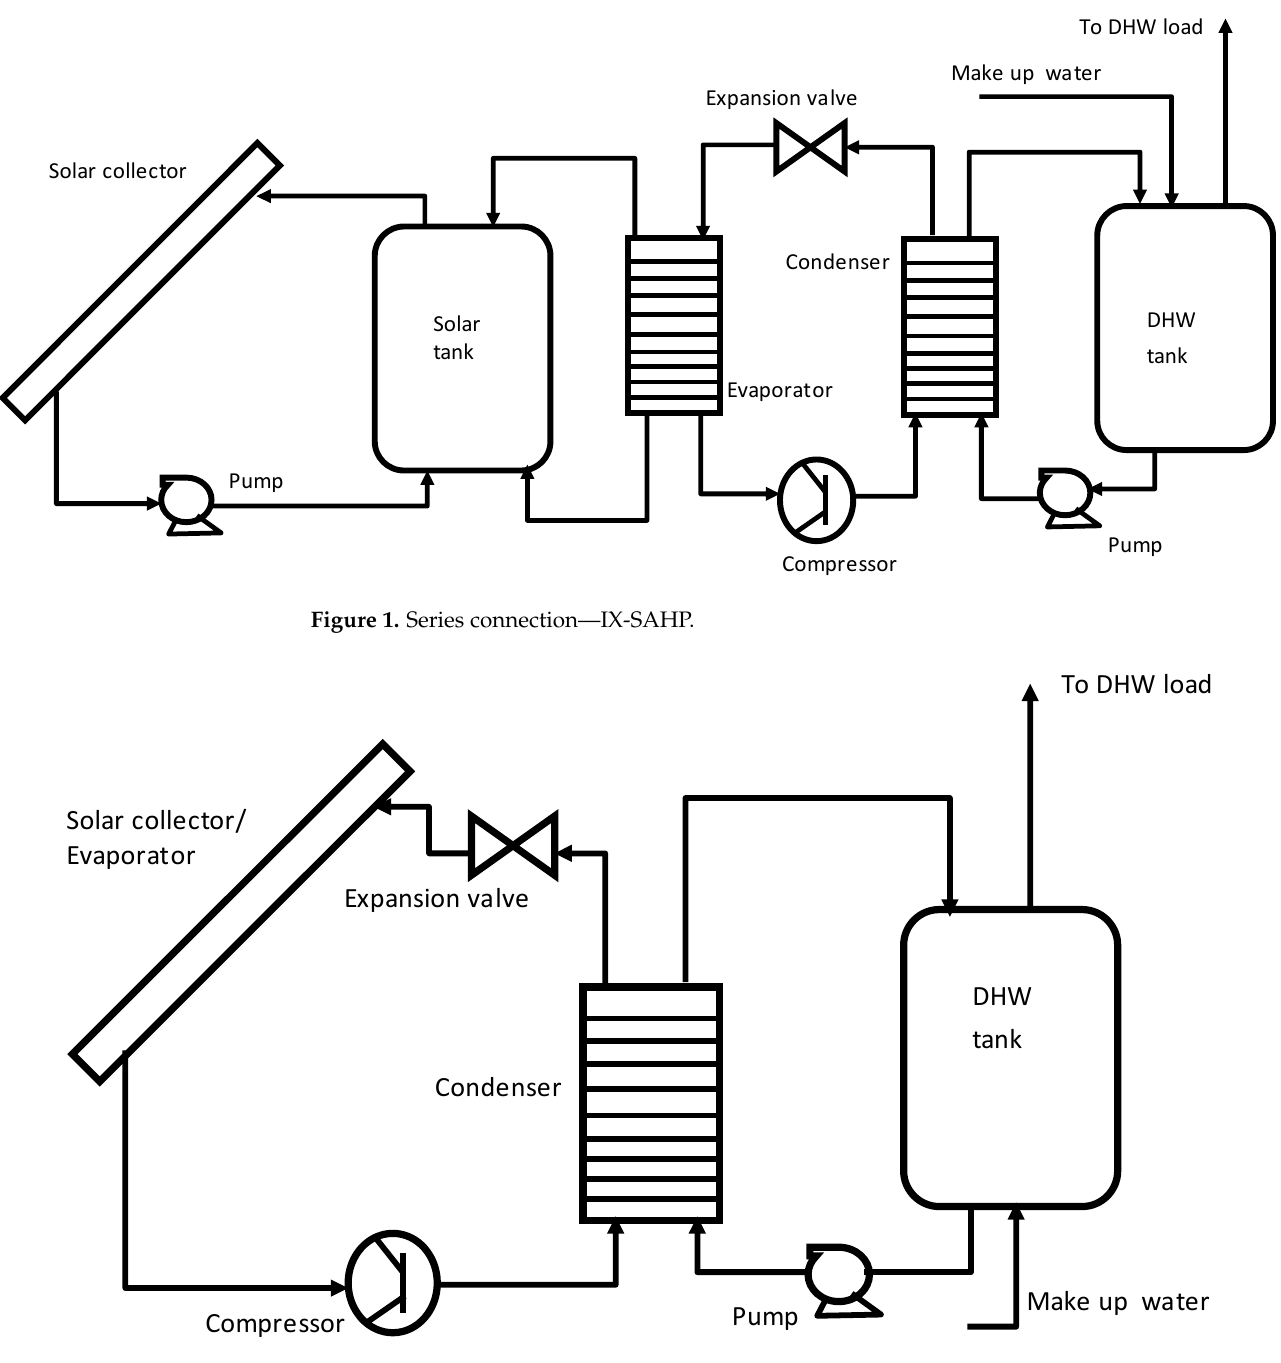
Figure 2. Series connection DX ‐ SAHP water heater.